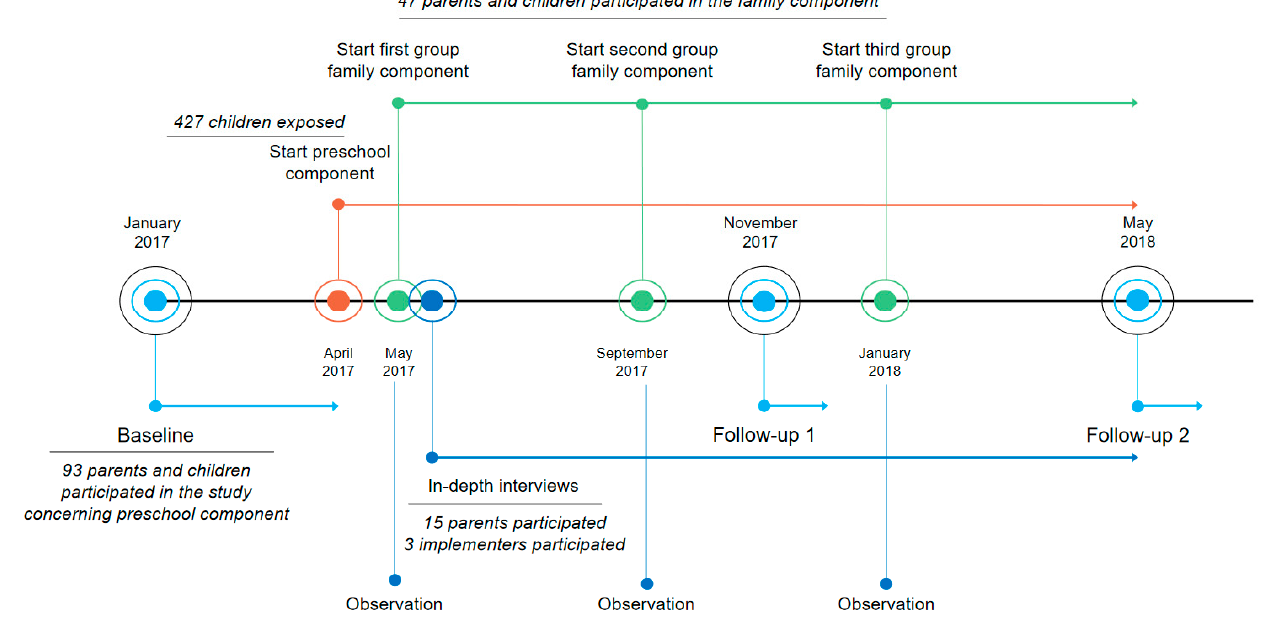
Figure 1. Visual representation of the timeline of all research and intervention activities concerning the SuperFIT approach.